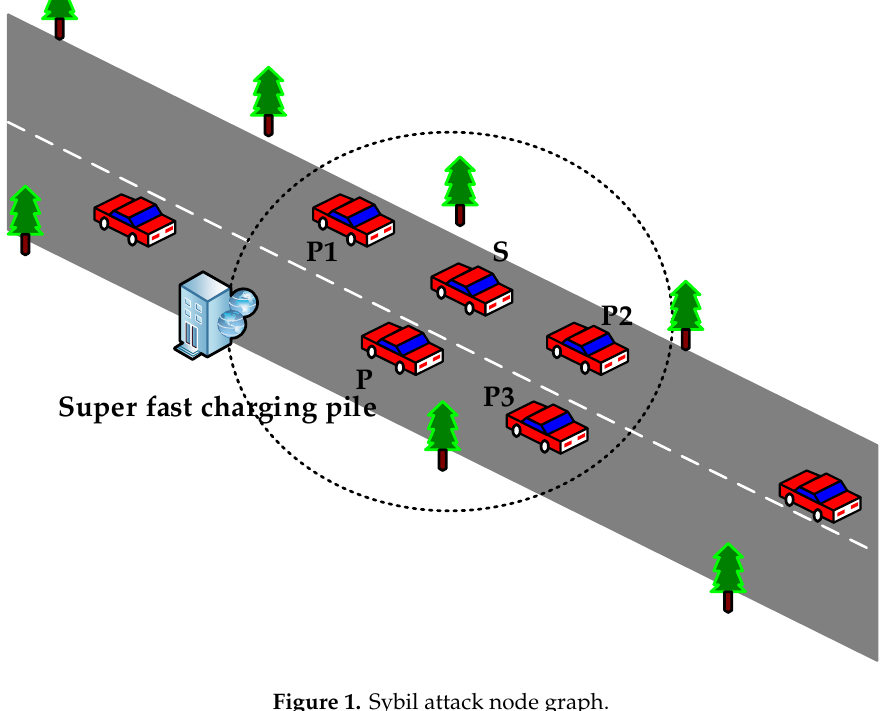
Figure 1. Sybil attack node graph.